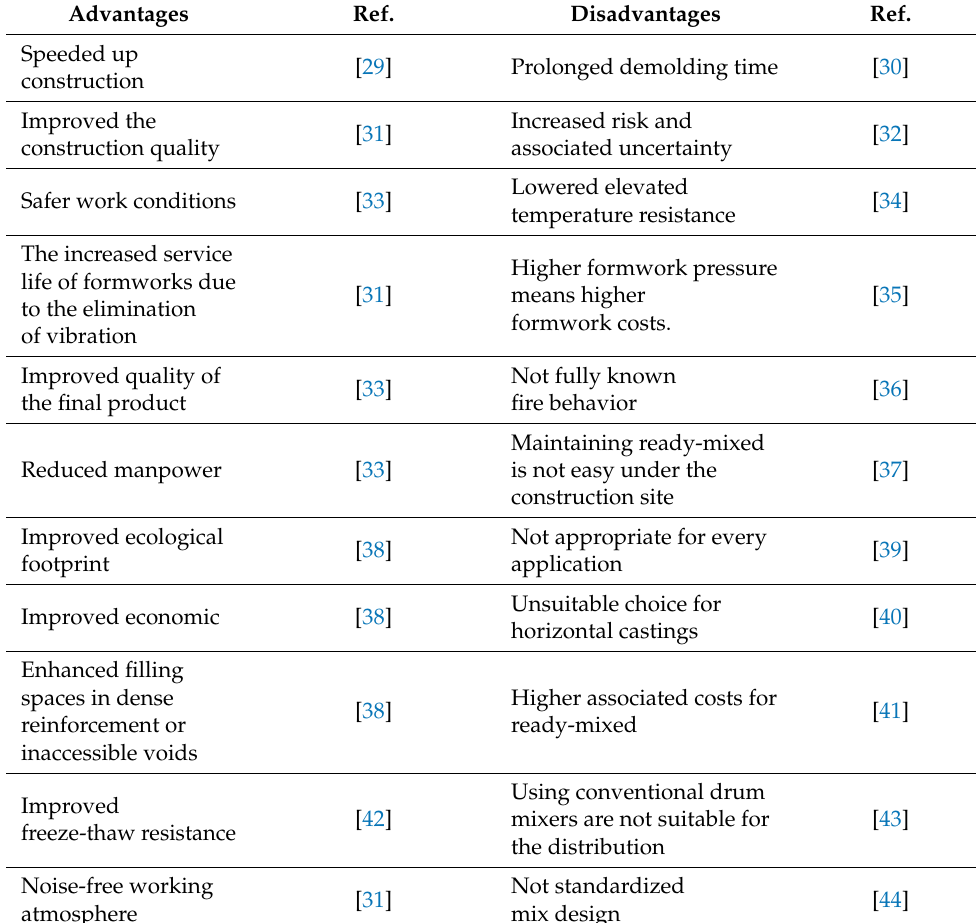
Table 1. The advantages and disadvantages of self-compacting concrete (SCC).